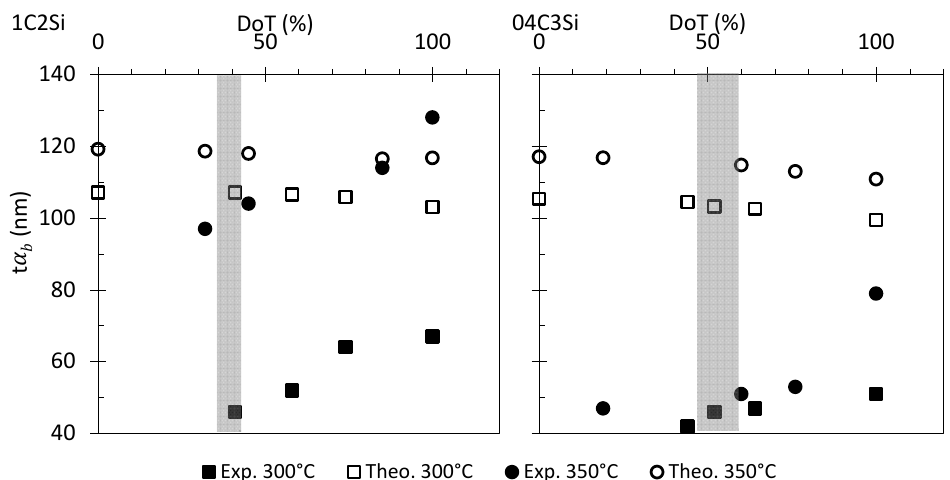
Materials 2021 , 14 , x FOR PEER REVIEW Figure 11. Bainitic ferrite plate thickness, t α b , as a function of the degree of transformation (DoT). Exp. and Theo. stand for experimental and theoretical values as described in the text. The shaded regions represent where the DRCL max is reached.